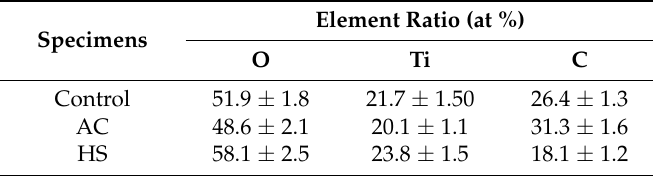
Table 1. Element percentages at the surface of different samples.